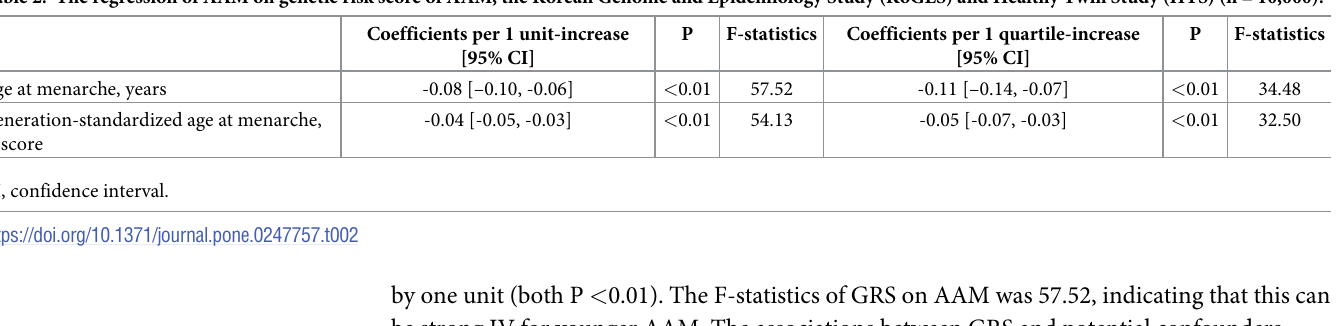
Table 2. The regression of AAM on genetic risk score of AAM, the Korean Genome and Epidemiology Study (KoGES) and Healthy Twin Study (HTS) (n = 10,000).